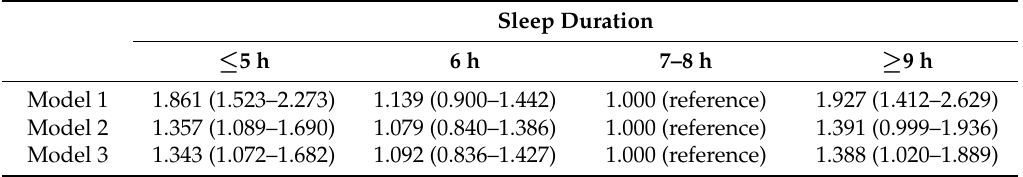
Table 2. Odds ratios and 95% confidence intervals for the presence of osteoarthritis according to sleep